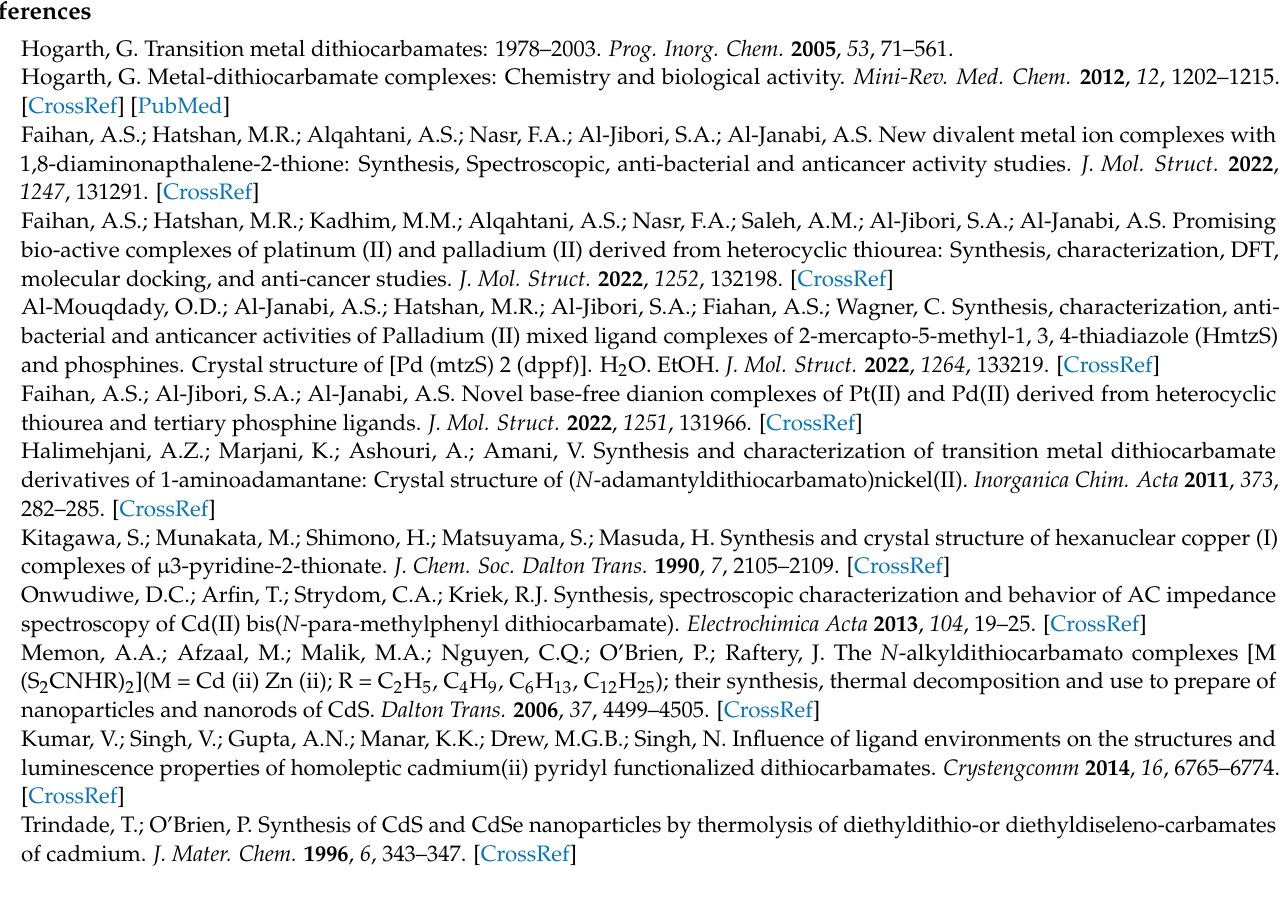
(1), Figure S2: 31 P nmr spectrum of complex (2), Figure S3: 31 P nmr spectrum of complex (3), Figure S4: 31 P nmr spectrum of complex (4), Figure S5: 31 P nmr spectrum of complex (5), Figure S6: 31 P nmr spectrum of complex (6), Figure S7: 31 P nmr spectrum of complex (7), Figure S8: 1 H nmr spectrum of complex (1), Figure S9: 1 H nmr spectrum of complex (2), Figure S10: 1 H nmr spectrum of complex (3), Figure S11: 1 H nmr spectrum of complex (5), Figure S12: 1 H nmr spectrum of complex (6) and Figure S13: 1 H nmr spectrum of complex